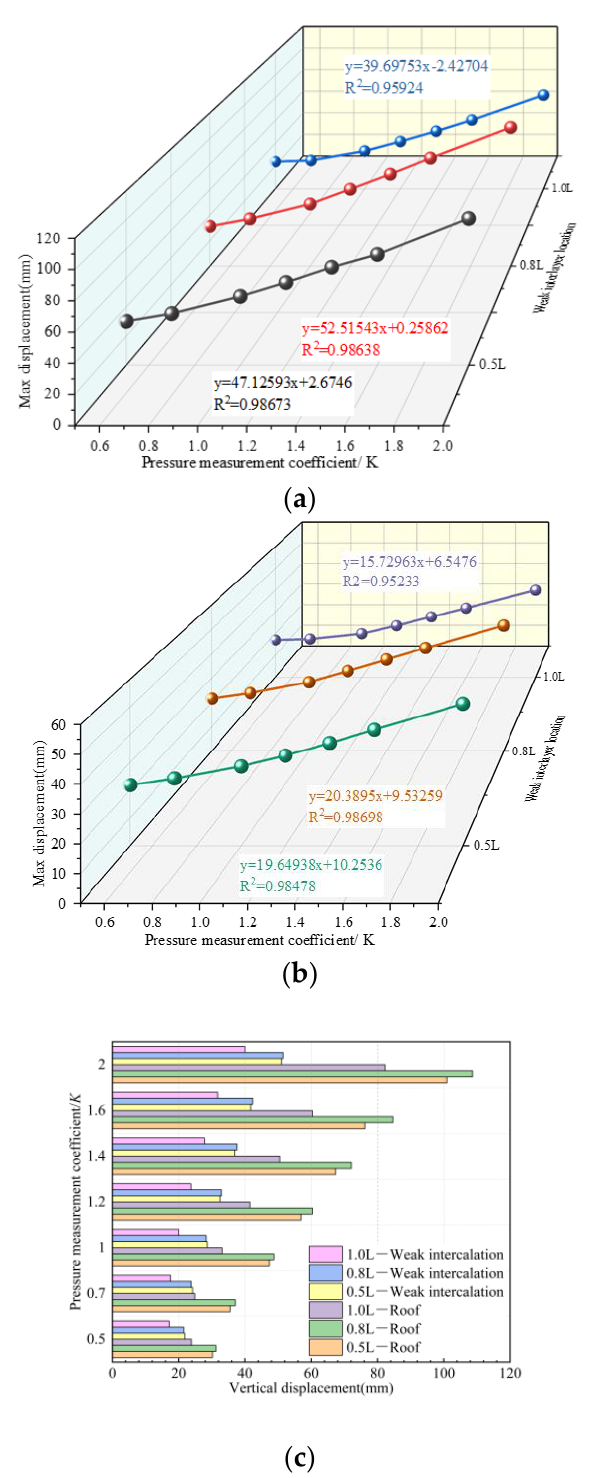
Figure 12. Relation between the roof deformation and pressure measurement coefficient. ( a ) Relationship between the vertical displacement of roadway roof and the pressure measurement coefficient. ( b ) Relationship between the vertical displacement of weak intercalation and the pressure measurement coefficient. ( c ) Comparison of maximum displacement under different k conditions.